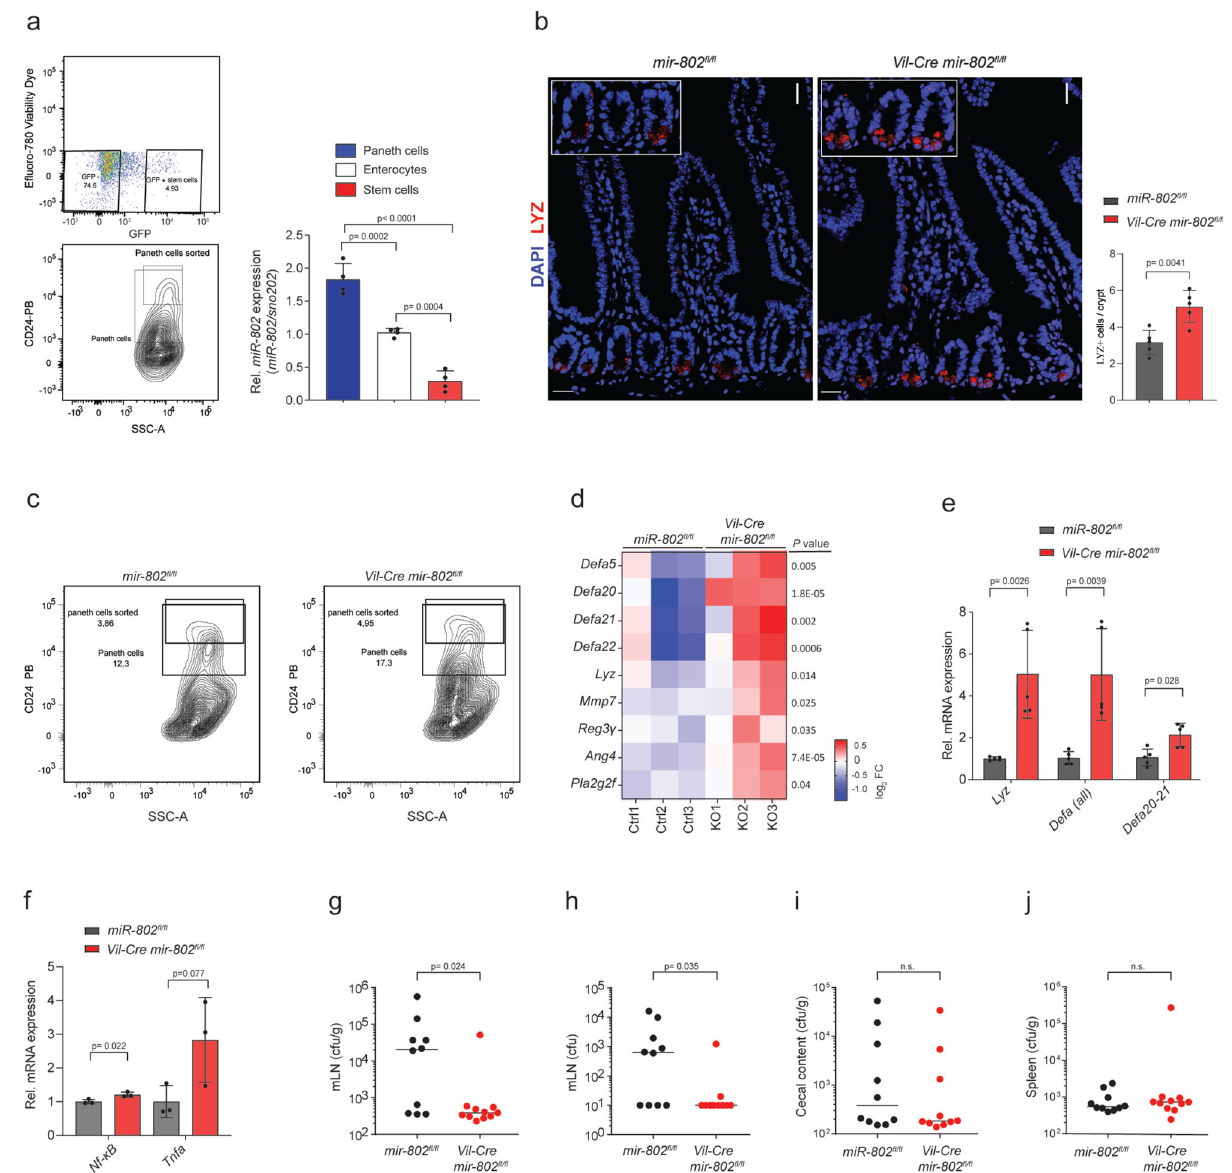
Fig. 2 miR-802 regulates intestinal Paneth cell expansion. a FACS sorting of Paneth cells, intestinal stem cells (ISCs), and enterocytes from dissociated single cells of jejunal crypts and epithelium. ISCs were isolated as Lgr5-EGFP + , EPCAM + , CD24low/CD31 − , Ter119 − , CD45 − , E fl uoro780 − and Paneth cells were sorted as CD24hi/SSChiLgr5-EGFP − , EPCAM + CD31 ‒ , Ter119 − , CD45 − , E fl uoro780 − cells. An enriched enterocyte population was obtained by isolating remaining CD24 − Lgr5-EGFP − , EPCAM + , CD31 − , Ter119 − , CD45 − , E fl uoro780 − cells. Right: Relative miR-802 levels in Paneth cells, enterocytes, and stem cells as determined by qRT-PCR ( n = 4 per group). Data representative of two independent experiments. b Immunohistochemistry of proximal jejunal sections of mir-802 fl / fl and Vil-Cre mir-802 fl / fl mice stained with anti-LYZ antibody. Top panel: Scale bar: 50 µ m. Right: Quanti fi cation of Paneth cell numbers/crypt ( n = 5 per genotype). Representative images and analysis of two independent experiments. c Percentage of sorted Paneth cells from single live cells from jejunal crypts of Vil-Cre mir-802 fl / fl and control mice. Paneth cells were gated as CD24 + , SSC hi ( n = 4 mice were pooled per genotype). Data representative of two independent experiments. d Heatmap showing mRNA expression, measured by RNA seq, of secreted proteins in Vil-Cre mir-802 fl / fl and control mice. Data are shown as Log2FC ( n = 3). e , f Relative expression of Lyz and defensins ( e ) and NF- κ B and TNFa ( f ), measured by qRT-PCR, in isolated enterocytes of Vil-Cre mir-802 fl / fl and control mice ( n = 5,5 for ( e ) and n = 3,3 for ( f )). Data representative of two independent experiments ( e ) and one experiment ( f ). g – j Colonization experiment of 10-week-old pathogen-free mir-802 fl / fl and Vil-Cre mir-802 fl / fl mice that were gavaged with 10 8 CFU of stationary phase Salmonella Typhimurium (strain SL1344) cultures grown overnight. Bacterial levels in spleen, feces and mesenteric lymph nodes (mLNs) were determined by dilution plating of homogenized tissues. Colony formation unit per gram mLN ( g ), colony-forming units per mLN ( h ), colony-forming units per gram of cecal content ( i ), and colony formation unit per gram of spleen ( j ) ( n = 10,11 for mir-802 fl / fl and Vil-Cre mir-802 fl / fl mice, respectively for ( g , h , j ) and n = 10 per genotype for ( i ), data are from two replicate experiments). Data are plotted as mean ± SD. Signi fi cance was evaluated by two-tailed t -test ( b , e , f ), one-way ANOVA with Tukey ’ s multiple comparisons test ( a ), or Mann – Whitney two-tailed test ( g – j ).